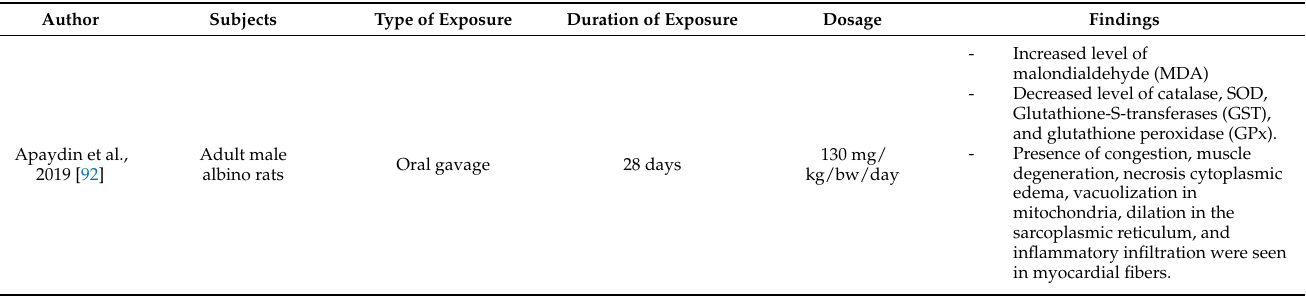
Table 2. BPA and cardiovascular